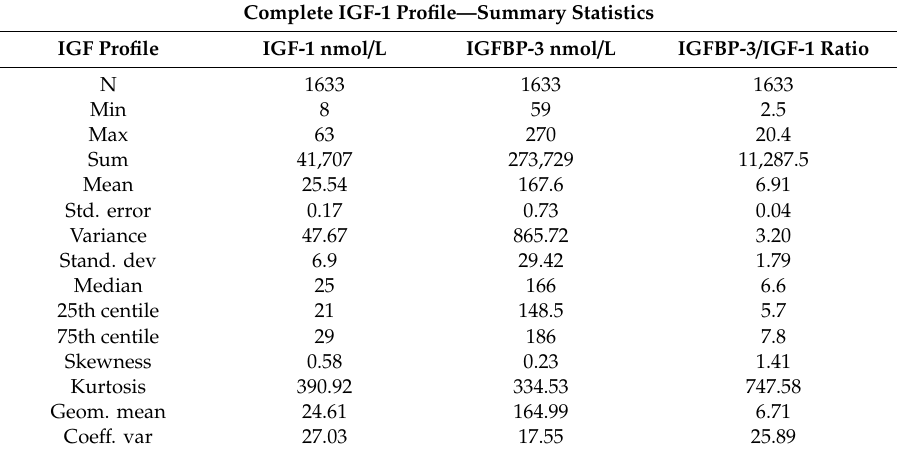
Figure 1. Flow diagram showing derivation of 1633 women who had IGF-1 and IGFBP-3 in early follicular phase of an Assessment Cycle undertaken prior to any definitive treatment. Table 1. Shows the summary statistics for the IGF-1 profile for the 1633 women who completed an Assessment Cycle prior to any definitive ART treatment and from which Figure 2 is derived. The IGF-1 a profile embraces serum IGF-1 levels (nmol / L) along with IGFBP-3 levels (nmol / L) and the IGF Ratio of IGFBP-3 / IGF-1. The statistics include ranges, mean levels, the medians and